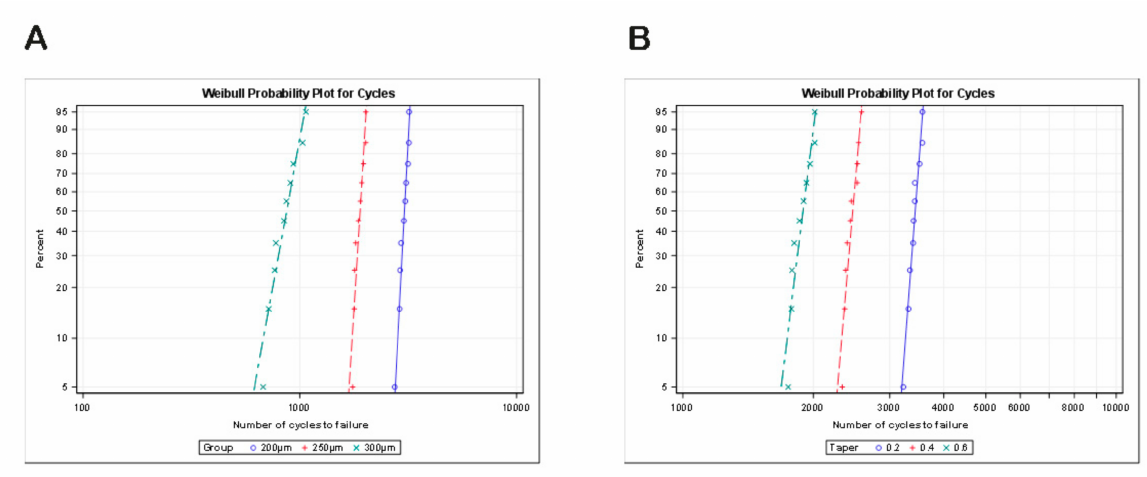
Figure 8. The Weibull probability plots of the number of cycles to failure for the ( A ) apical diameter and ( B ) taper study groups.